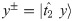
Simulation of DSD realized degradation reactions.(A) Concentration of y±=|t2^y〉 over time under deg = z
± = 1 nM. (B) Concentration of y±=|t2^y〉 over time under deg = z
± = 100 nM. The three curves in each case correspond to different initial concentrations y(0)± = 10, 50, and 100 nM.